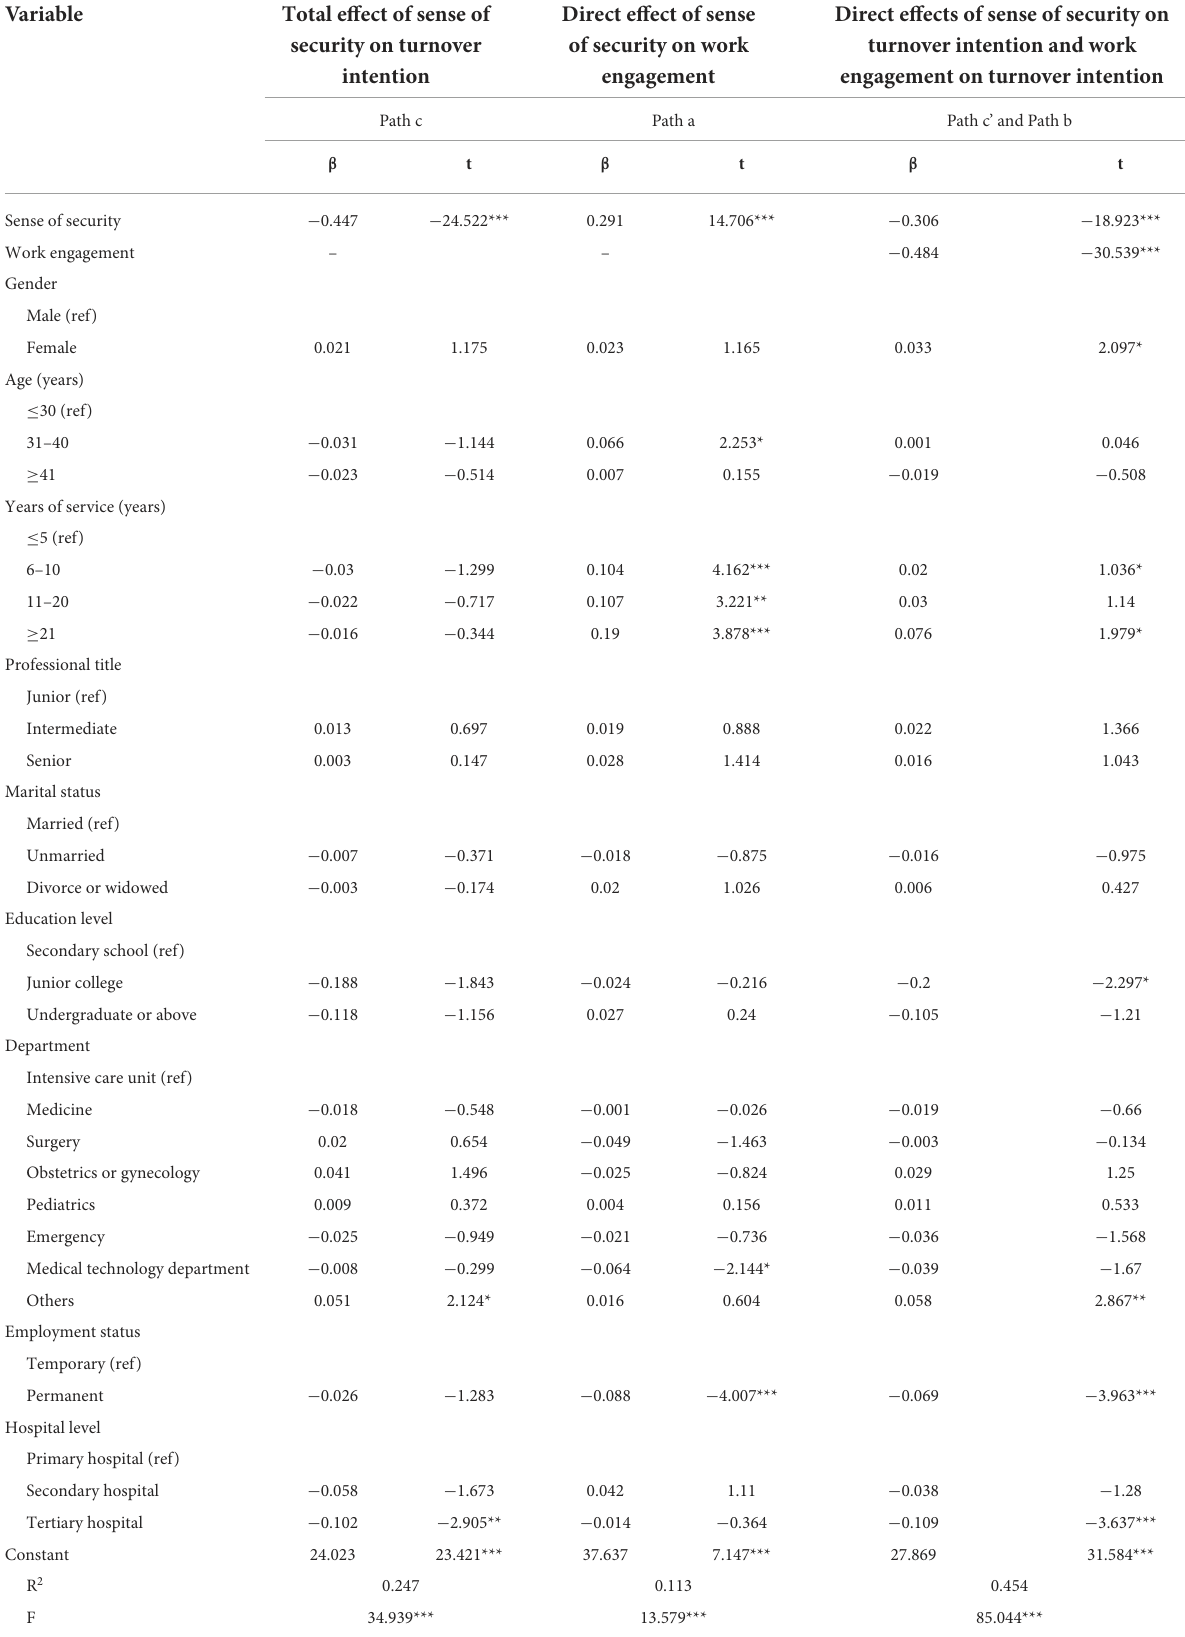
TABLE 3 Results of the regression models testing the mediation hypothesis ( N = 2480). Variable Total effect of sense of Direct effect of sense Direct effects of sense of security on security on turnover of security on work turnover intention and work intention engagement engagement on turnover intention Path c Path a Path c’ and Path